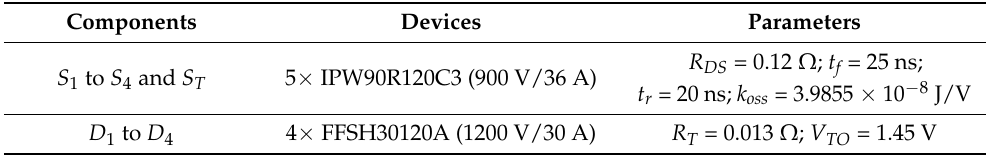
Table 2. Power semiconductors chosen for this study.